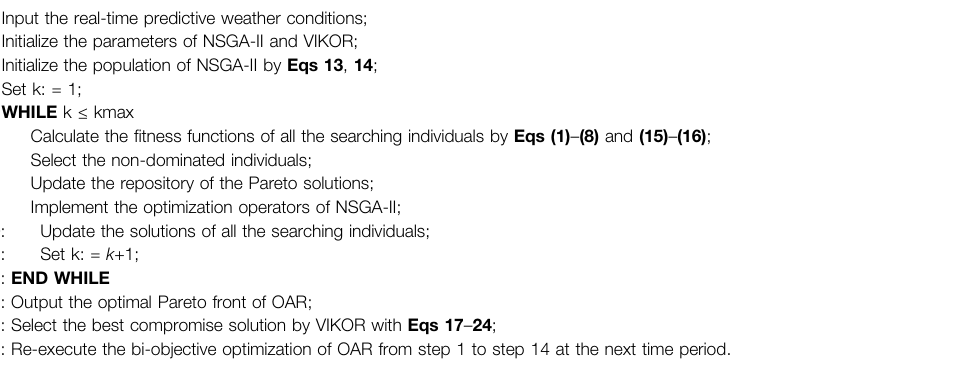
TABLE 1 | The speci fi c execution procedure of NSGA-II and VIKOR for OMAR.